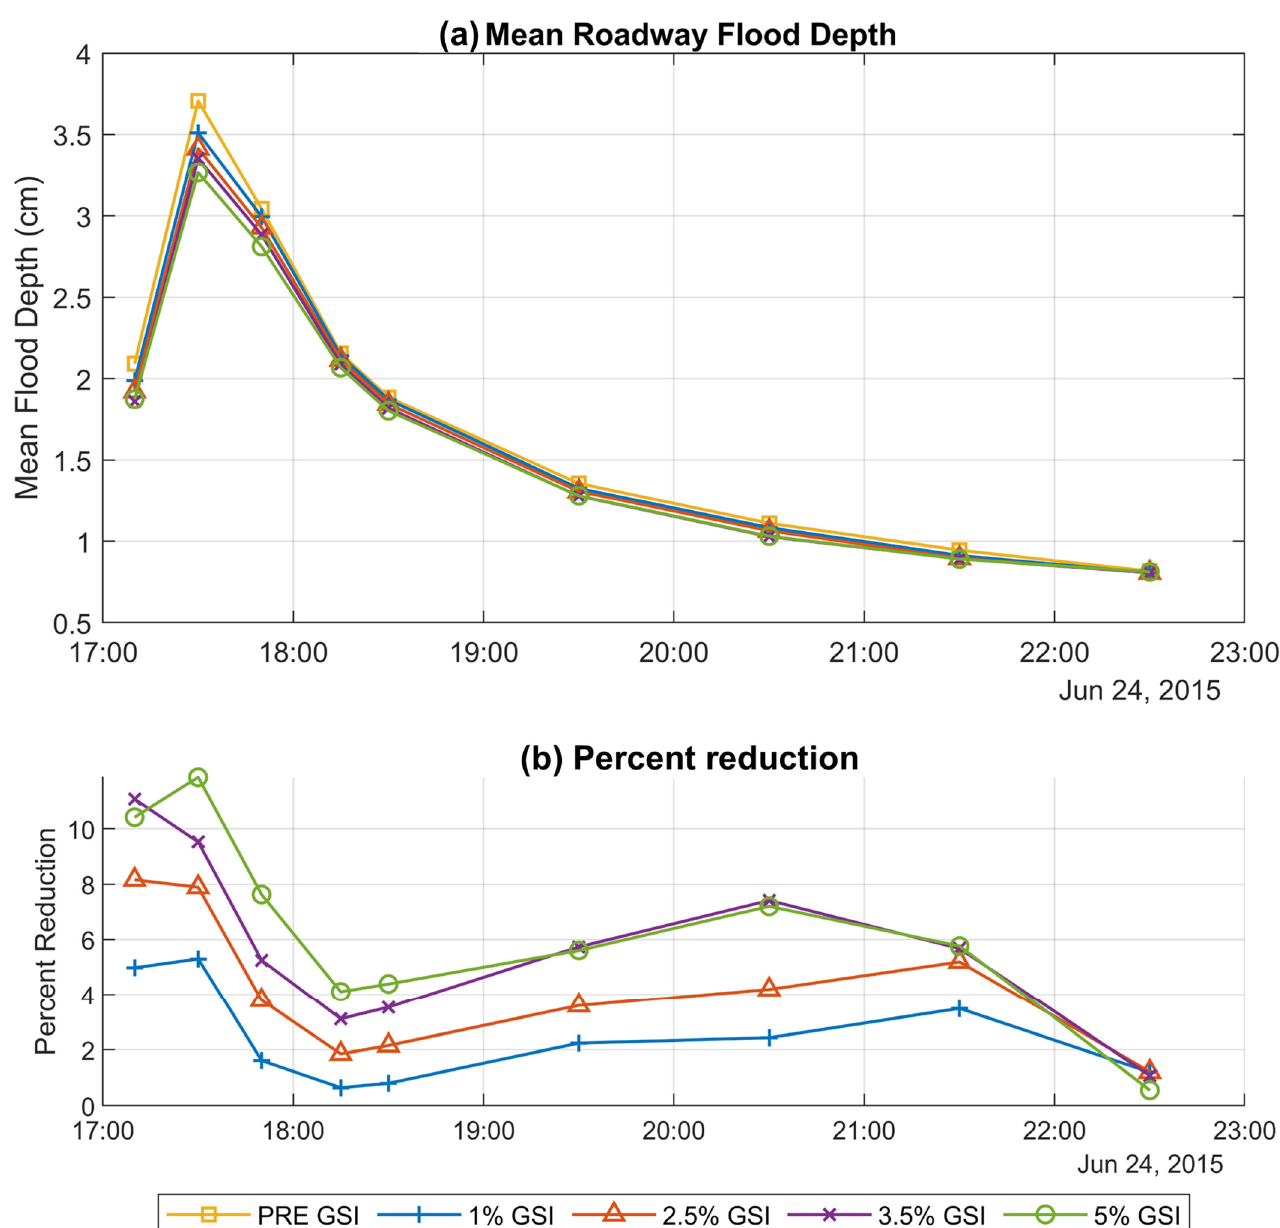
Figure 6. ( a ) Mean roadway flood depth (cm) at select times throughout the simulation period; ( b ) Percent reduction in mean roadway flood depth for GSI scenarios compared to the pre-GSI scenario.